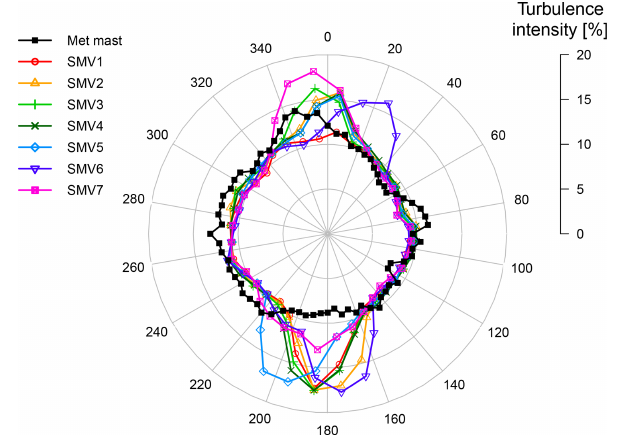
Figure 9. TI distribution at each wind turbine used during the opti- mization process. This rose is obtained for a wind speed of 8ms − 1 only, but similar roses were calculated for each wind speed bin. Am- bient TI measured at the met mast is also plotted for